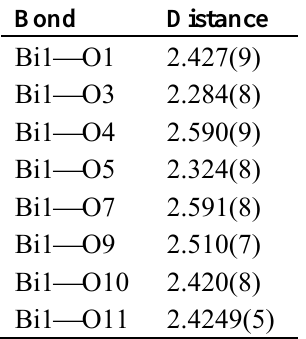
Table 1. Selected bond lengths (Å) for 1 with estimated standard deviations in parentheses.